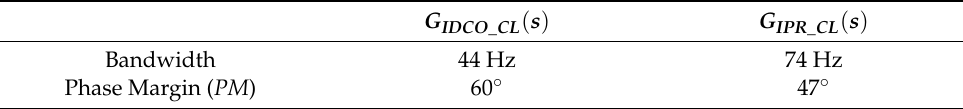
Figure 13. Bode diagram of the transfer functions based on the IDCO method and the proposed IPR method: ( a ) open-loop transfer functions, ( b ) closed-loop transfer functions. Table 2. Comparisons of the transfer functions.